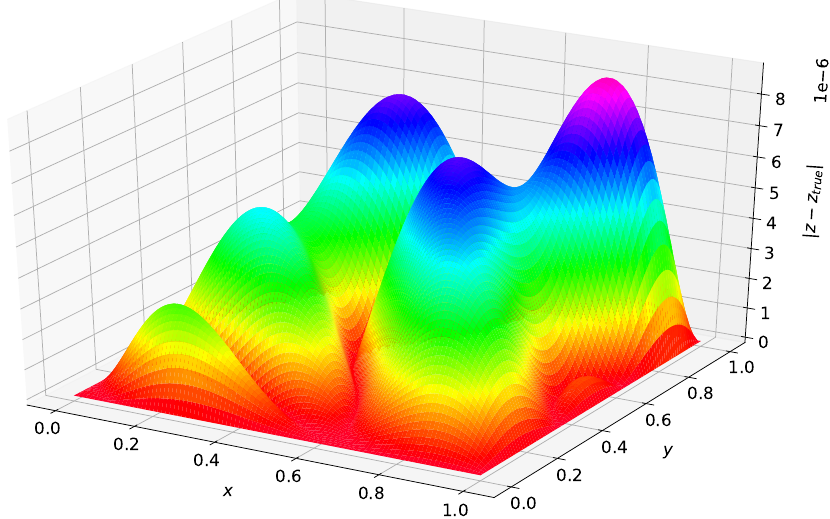
Figure 4. Problem 1 solution error using Deep TFC solution